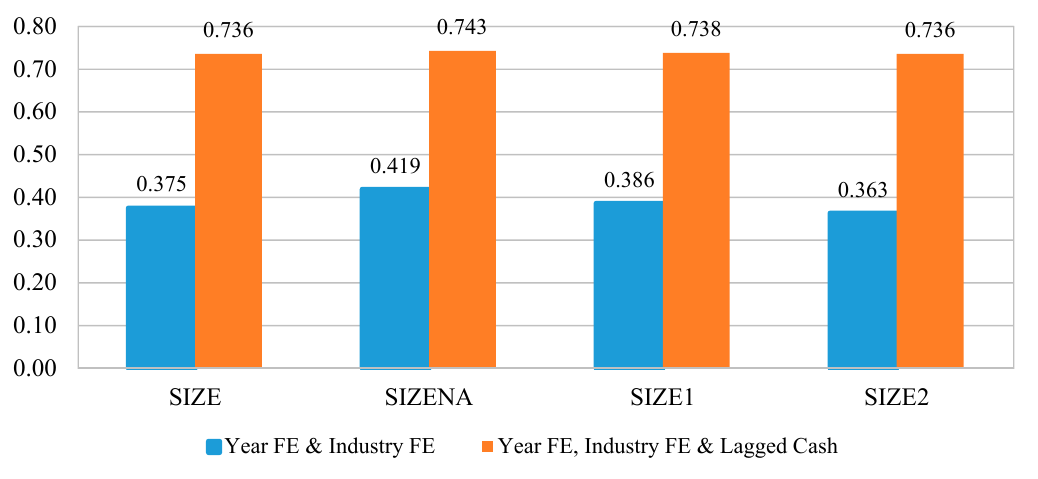
Figure A2. The trends of firm size measures (in original terms). Note: This figure provides the time series of the average firm size measures in original terms (£ Millions) for all the firms in the sample data.